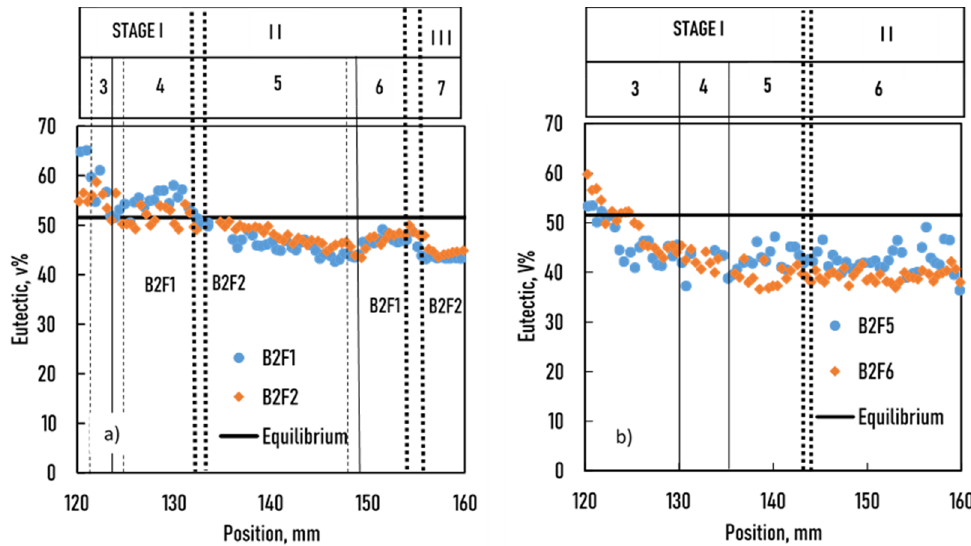
Figure 7. The measured amount of eutectic vs. position in the sample ( a ): samples B2F1 and BF2, ( b ): samples B2F5 and B2F6.